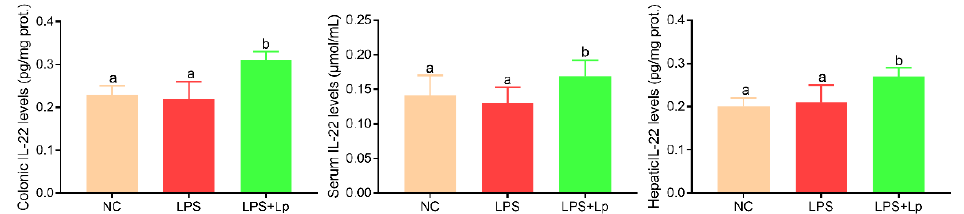
Figure 2. Effect of L. paracasei CCFM1223 pretreatment on the colonic, serum, and hepatic IL-22 levels in LPS-treated mice (n = 8). Values with different letters are significantly different ( p < 0.05).